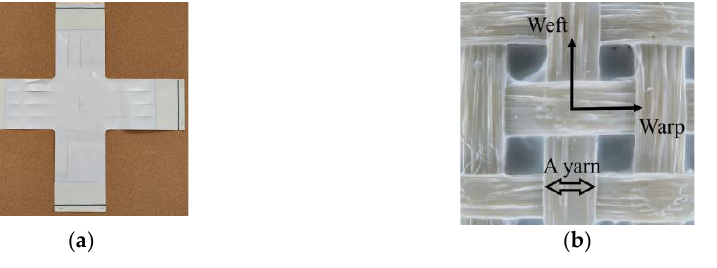
Figure 4. UN-5100 material. ( a ) A specimen made of UN-5100. ( b ) The microstructure of the UN-5100 material.